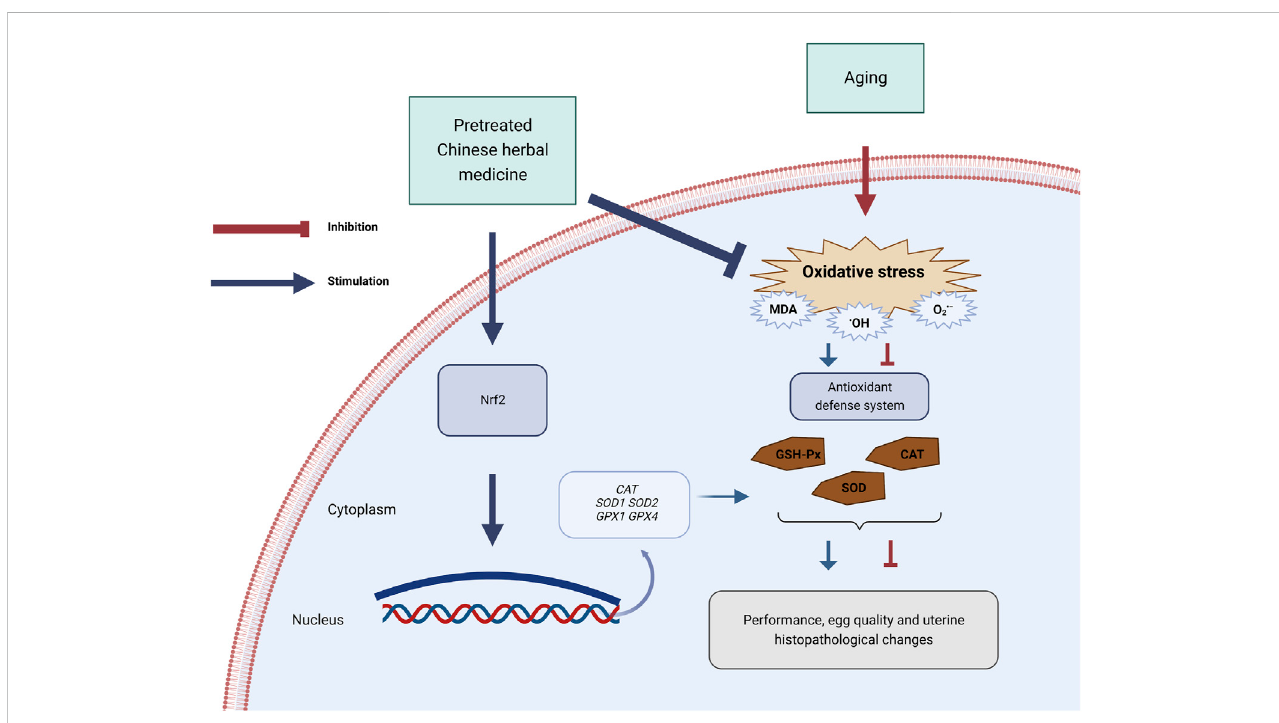
FIGURE 9 Schematicdiagramsummarizingthemechanismsbywhich pretreatedChineseherbalmedicine(PCHM) promotetheantioxidant defensesysteminlate laying hens. The antioxidant defense system is downregulated in the natural aging process in laying hens. PCHM attenuated the oxidative stress in the uterus via the activation of the nuclear factor-erythroid 2-related factor 2 ( Nrf2 ) pathway to increase the age-related up-produce in commercial laying hens. CAT, catalase; GSH-Px, glutathione peroxidase; SOD, superoxide dismutase; MDA, malondialdehyde; SOD1 , Cu-Zn superoxide dismutase; SOD2 , Mn superoxide dismutase; CAT , catalase; GPX1 , glutathione peroxidase 1; GPX4 , peroxidase 4. Figures generated with BioRender